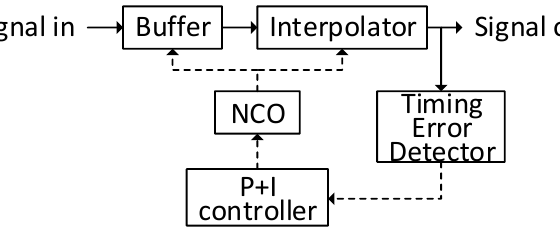
Figure 1. Timing recovery implementation.